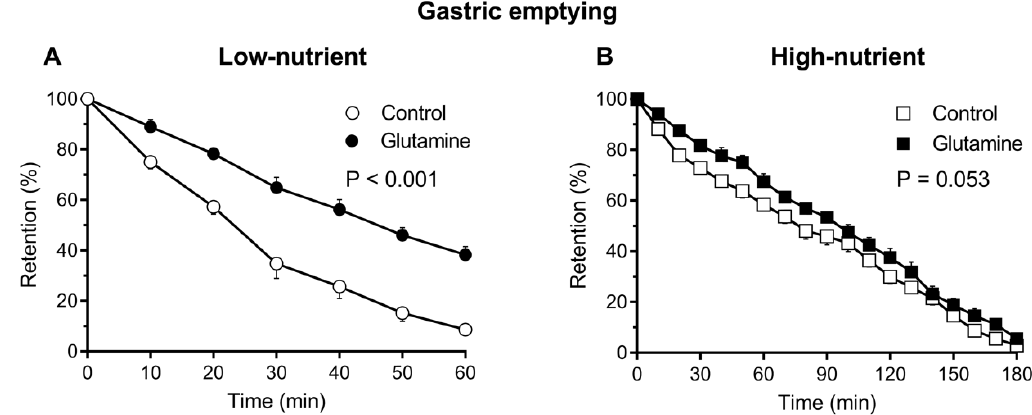
Figure 1. Gastric emptying of A low-nutrient ( ○ ), low-nutrient with glutamine ( ● ) and B high-nutrient ( □ ) and high-nutrient with glutamine ( ■ ). Data are mean ± SEM represented by vertical bars. Ingestion of low-nutrient drink with glutamine slowed gastric emptying significantly compared to low-nutrient drink alone (ANOVA, p < 0.001). There was a trend for slowing of gastric emptying of the high-nutrient drink by glutamine (ANOVA, p = 0.053).